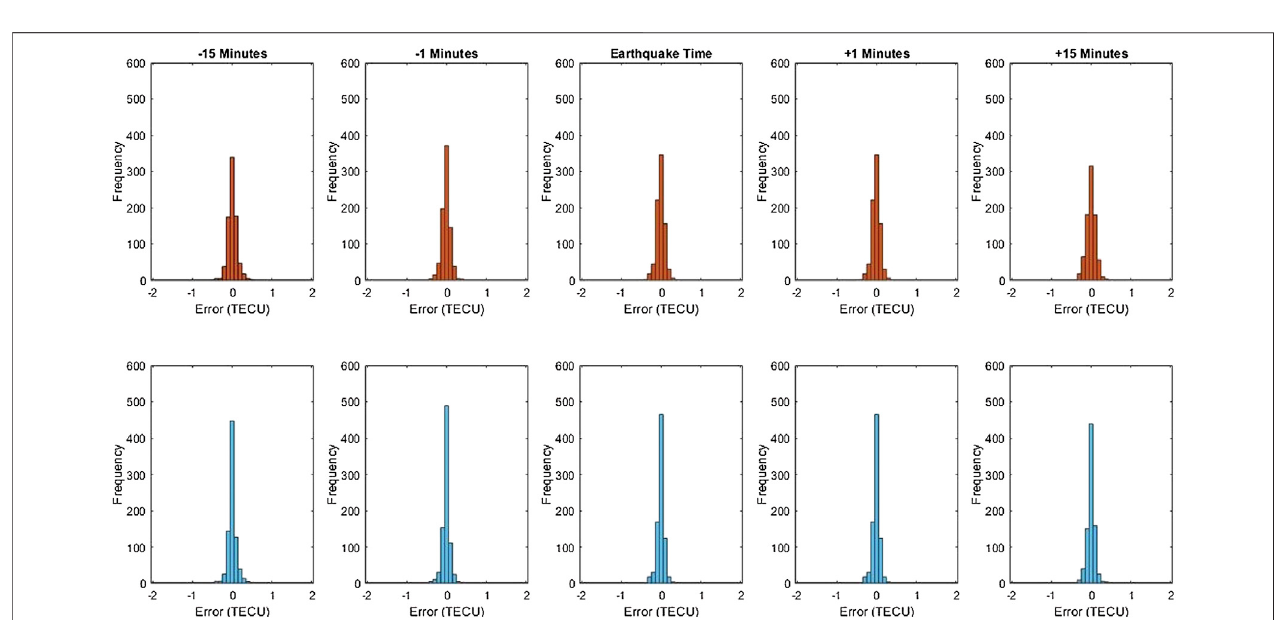
FIGURE 8 | Distribution of STEC anomaly input (orange) and post- fi t residue